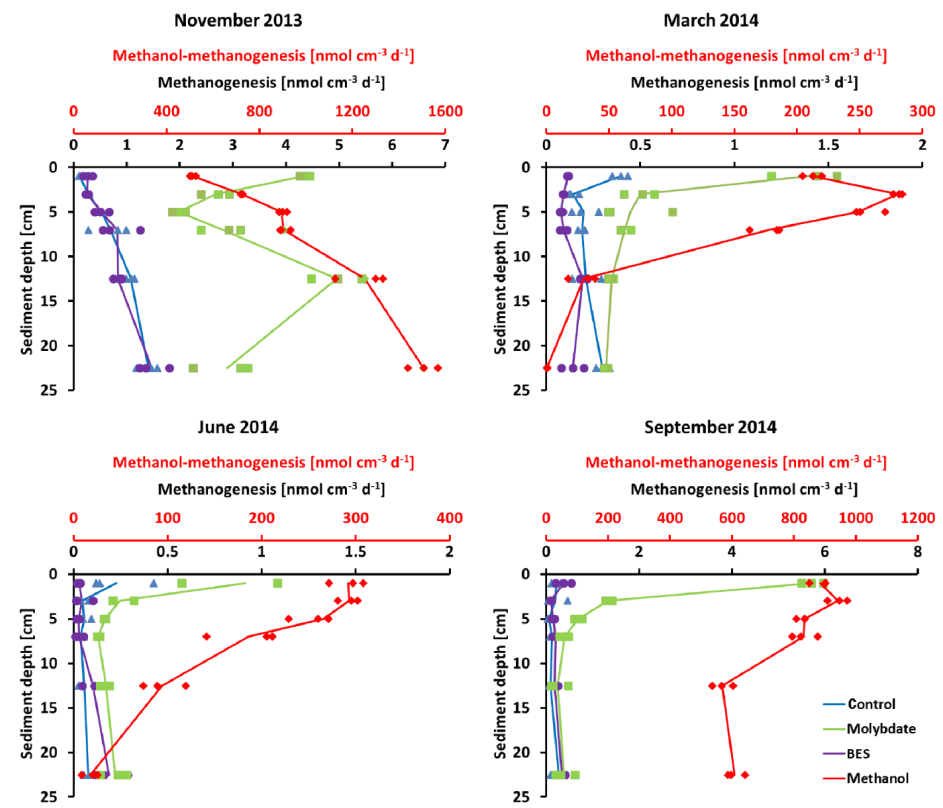
Figure 6. Potential methanogenesis rates versus sediment depth in sediment sampled in November 2013, March 2014, June 2014, and September 2014. Presented are four different types of incubations (treatments): control (blue symbols) describes the treatment with sediment plus artificial seawater containing natural salinity (24 PSU) and sulfate concentrations (17mM), molybdate (green symbols) is the treatment with the addition of molybdate (22mM), BES (purple symbols) is the treatment with 60mM BES addition, and methanol (red symbols) is the treatment with the addition of 10mM of methanol. Shown are triplicates per depth interval and the mean as a solid line. Please note the different x axis for the methanol treatment